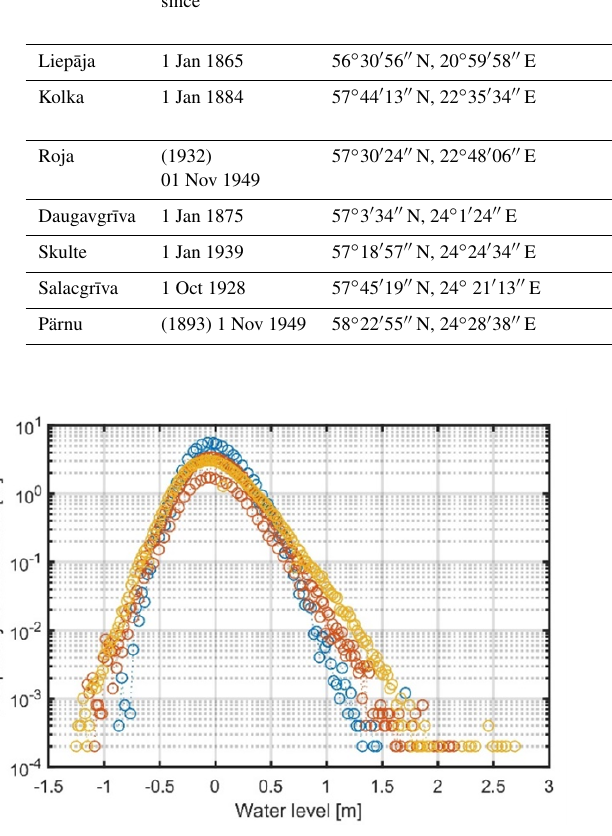
Figure 2. Empirical distributions of the frequency of occurrence of different water levels at Liep¯aja (blue), Daugavgr¯ıva (red), and Pärnu (yellow). Adapted from Männikus et al.